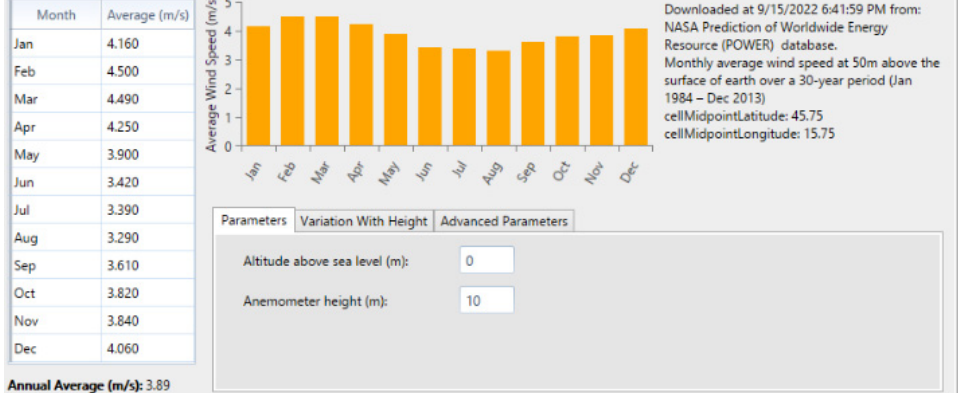
Figure 4. Monthly Average Wind Speed Data.